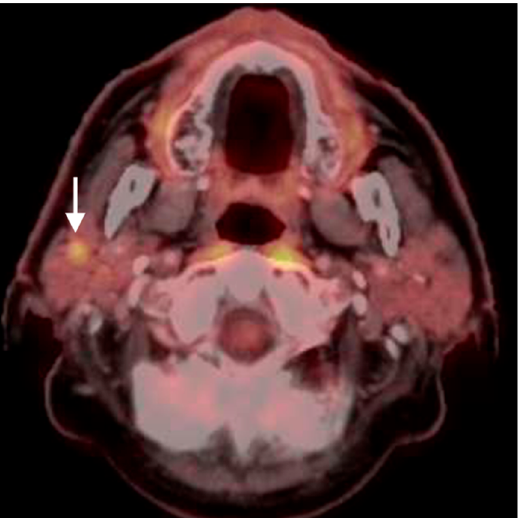
Figure 27. Warthin tumor (papillary cystadenoma lymphomatosum). On axial FDG PET_CT, a Warthin tumor of the right parotid is a hypermetabolic nodule (white arrow).